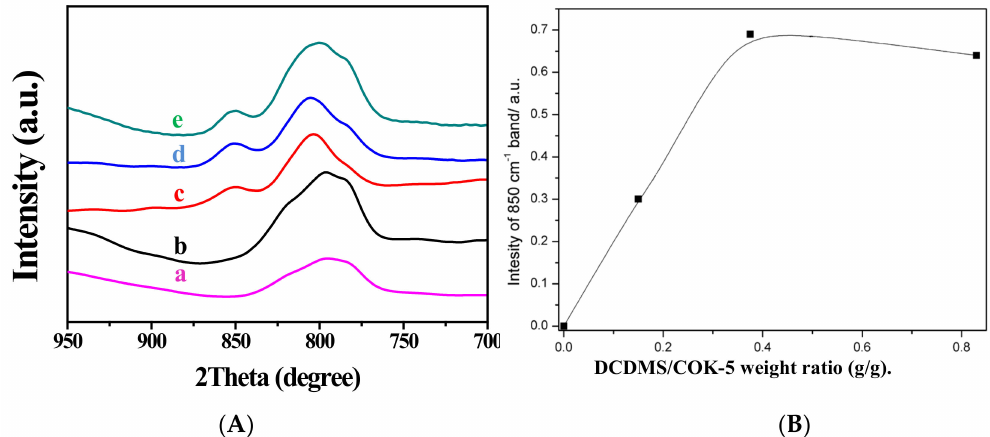
Figure 8. ( A ) IR spectra of ( a ) COK-5, ( b ) IEZ-COK-5-0, ( c ) IEZ-COK-5-0.185, ( d ) IEZ-COK-5-0.375, ( e ) IEZ-COK-5-0.830. ( B ) Intensity of 850 cm − 1 band as a function of the amount of DCDMS used in the silylation of COK-5. Reprinted with permission from ref. [40]. Copyright 2015,